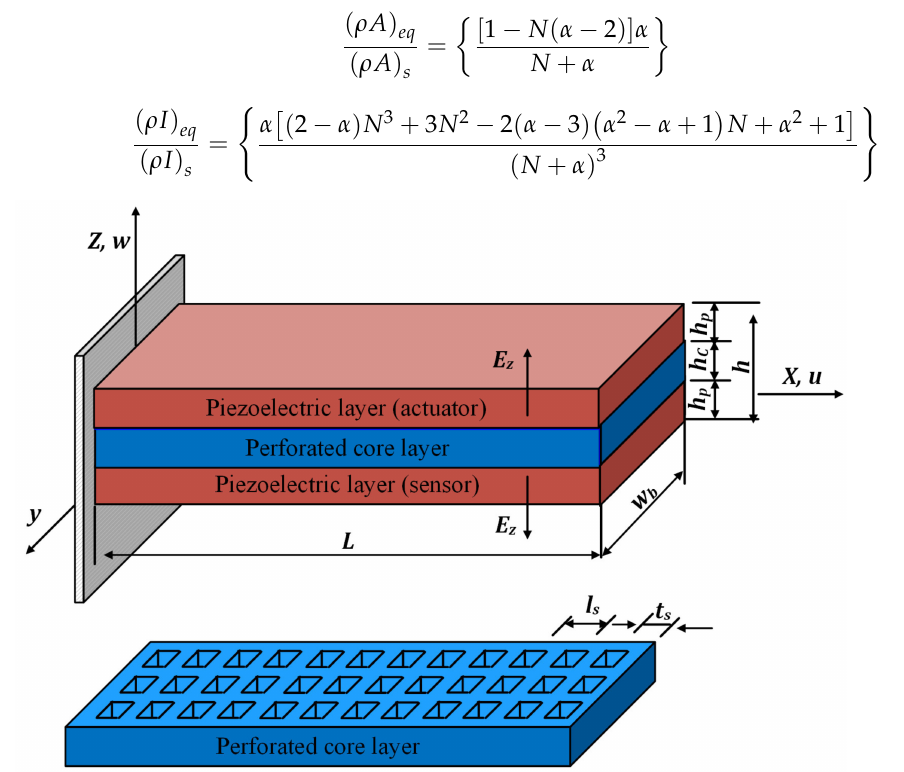
Figure 1. Geometry of a perforated, multilayered piezoelectric smart composite